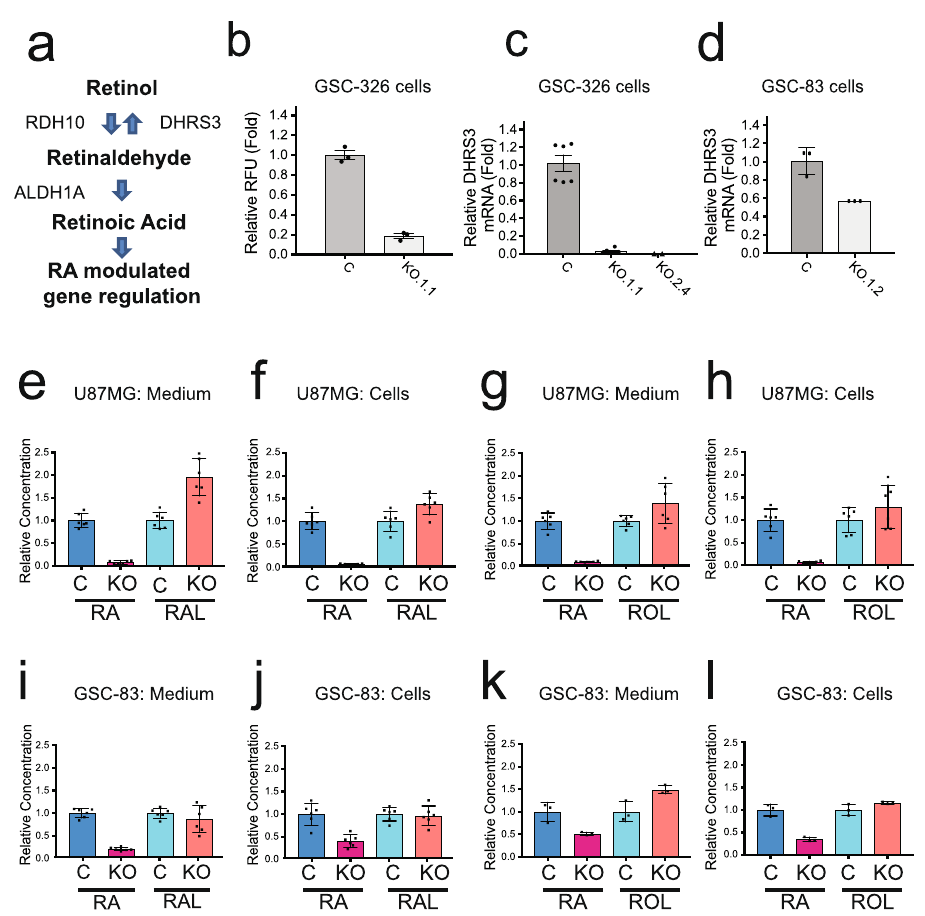
Fig. 3 ALDH1A3 regulates RA synthesis in MES glioma stem cells. a Enzymes involved in the retinoic acid (RA) biosynthesis pathway. b GSC-326 control and GSC-326/ALDH1A3-KO cells were co-transfected with the reporter vector of RARE-Luciferase and Renila-Luciferase (the control vector). Forty-eight (48) hours after transfection, the luminescence was measured and normalized to the GSC-326 control cells as 1 ( n = 3 technical replicates). c Quantitative RT-PCR analysis of the DHRS3 mRNA expression in GSC-326/ALDH1A3-KO single-cell clones. (Control: n = 6; KO.1.1, n = 6; KO.2.4, n = 2; technical replicates). d Quantitative RT-PCR analysis to evaluate DHRS3 mRNA expression in GSC-83/ALDH1A3-KO single-cell clones ( n = 3, technical replicates). e – h Changes in metabolism of exogenously supplied retinoids in U87MG/ALDH1A3-KO cells. Retinol (ROL, 10 µ M) ( e , f ) or retinoic acid (RA, 5 µ M) ( g , h ) was added to U87MG/ALDH1A3-KO and control cells. After culturing, cells and culture medium were harvested separately, and retinoids were extracted and analysed by normal phase HPLC. The output of metabolites was compared with the control U87MG cell line normalized as 1 ( n = 6, technical replicates). i – l Changes in metabolism of exogenously supplied retinoids in GSC-83/ALDH1A3-KO cells. The GSC-83/ALDH1A3-KO and control cells were treated with ROL (10 µ M) ( i , j ; n = 6, technical replicates) or retinaldehyde (RAL, 5 µ M) ( k , l ; n = 3, technical replicates) and the output of metabolites